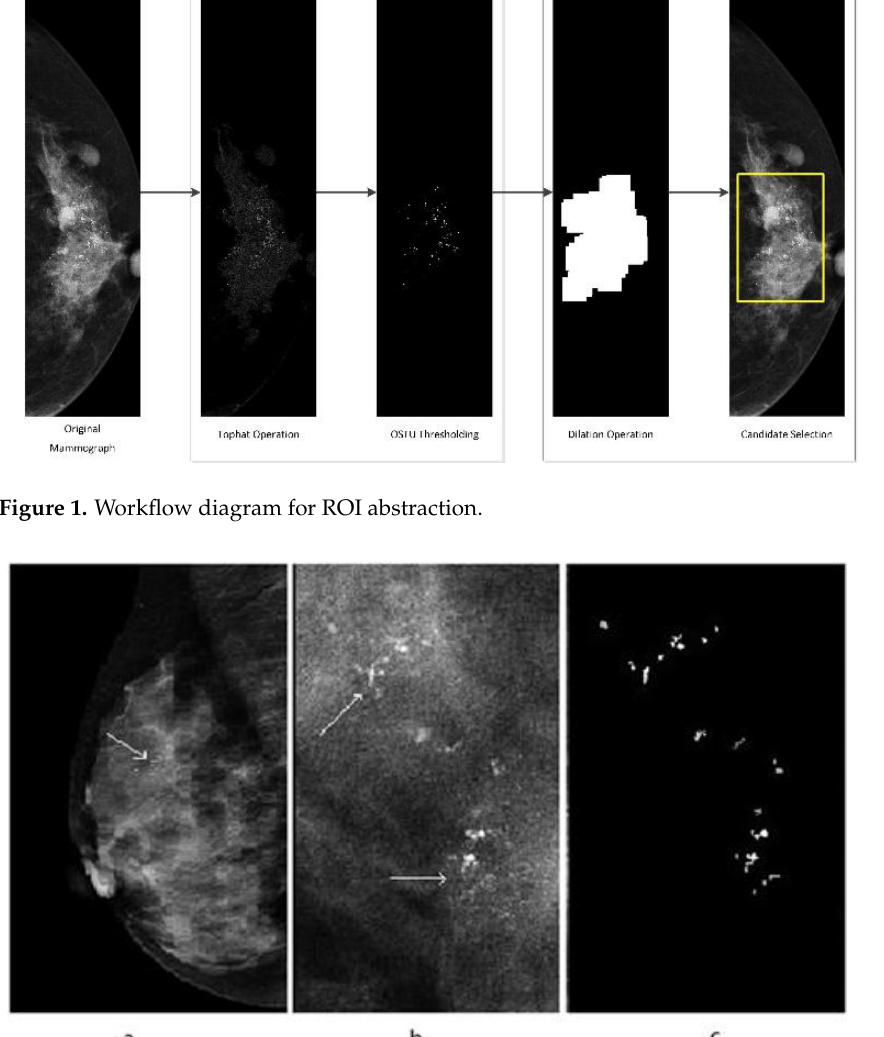
Figure 2. An illustrative example showing segmentation of microcalcifications in a mammogram of the left breast of a 56-year-old patient. ( a ) The mediolateral oblique (MLO) view shows clustered coarse and low-density microcalcifications (indicated by thin arrows). ( b ) The image shows the region of suspicious microcalcifications (indicated by thin arrows). ( c ) The segmented microcalcifications from ( b ) are used to characterize the features.